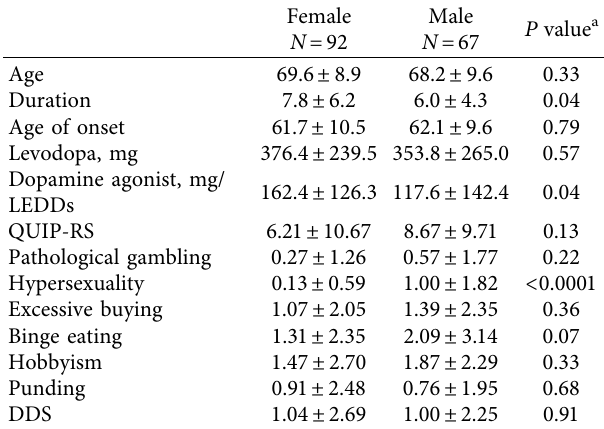
Table 3: Comparison between